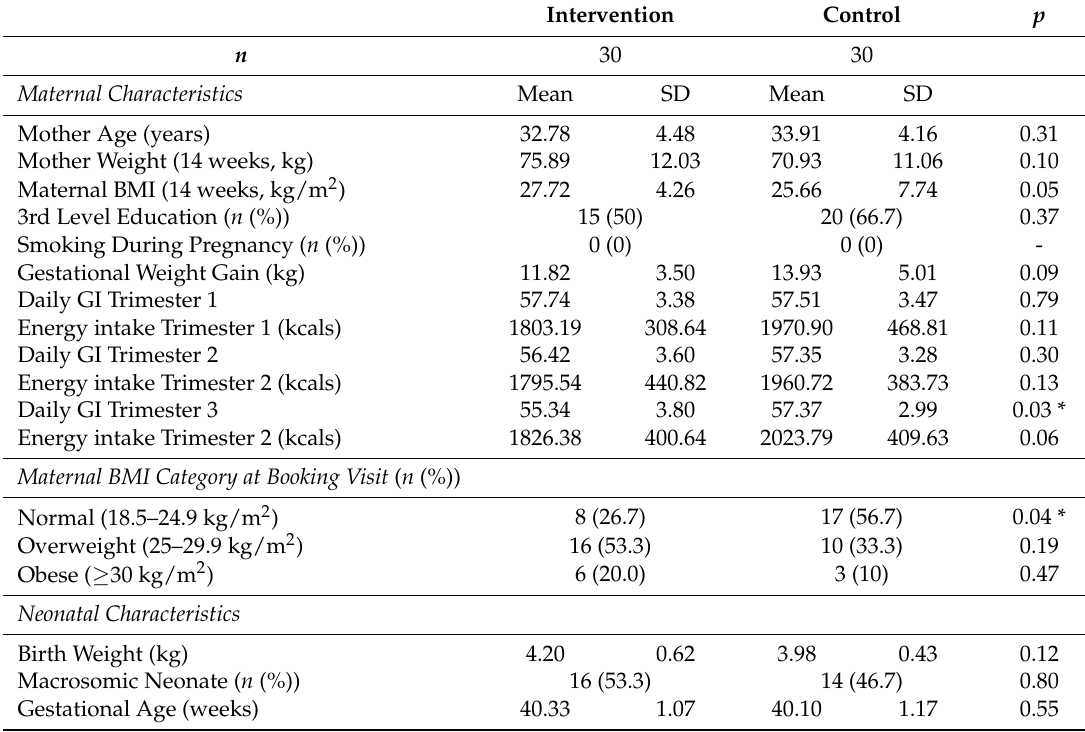
Table 1. Characteristics of the mothers and neonates in the ROLO Study cohort ( n = 60). Intervention